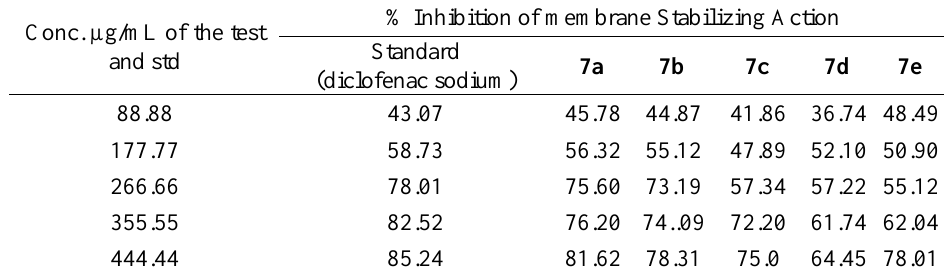
Table 1. Membrane stabilising activity % Inhibition of membrane Stabilizing Action Conc. µg/mL of the test and